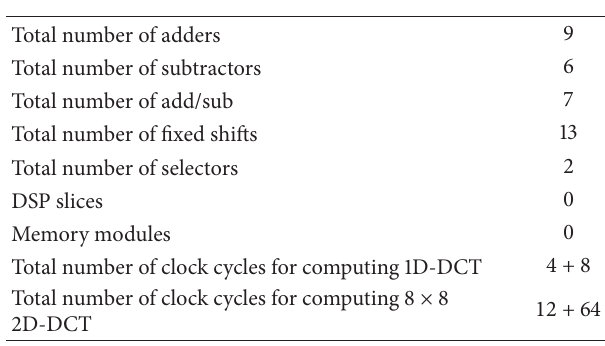
Table 6: Resource usages and DCT computing cycles of the proposed architecture.